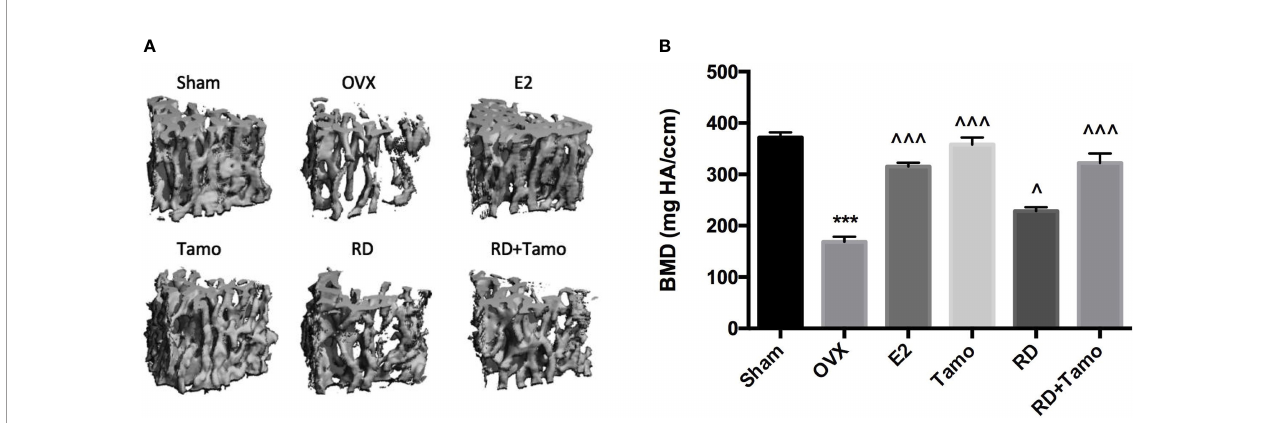
FIGURE 2 | Estrogenic effects of RD, tamoxifen, and their combinations on bone microarchitecture and bone mineral density of the lumbar spine in mature ovariectomized rats. Upon treatment, lumbar vertebra was collected. Bone microarchitecture (A) and bone mineral density (BMD) of the lumbar vertebra (B) were measured by micro-CT. Data were expressed as mean ± SEM. n = 6 to 10. *** p < 0.001 vs. Sham; ^ p < 0.05, ^^^ p < 0.001 vs. OVX. p -value of two-way ANOVA: 0.0013 for BMD.